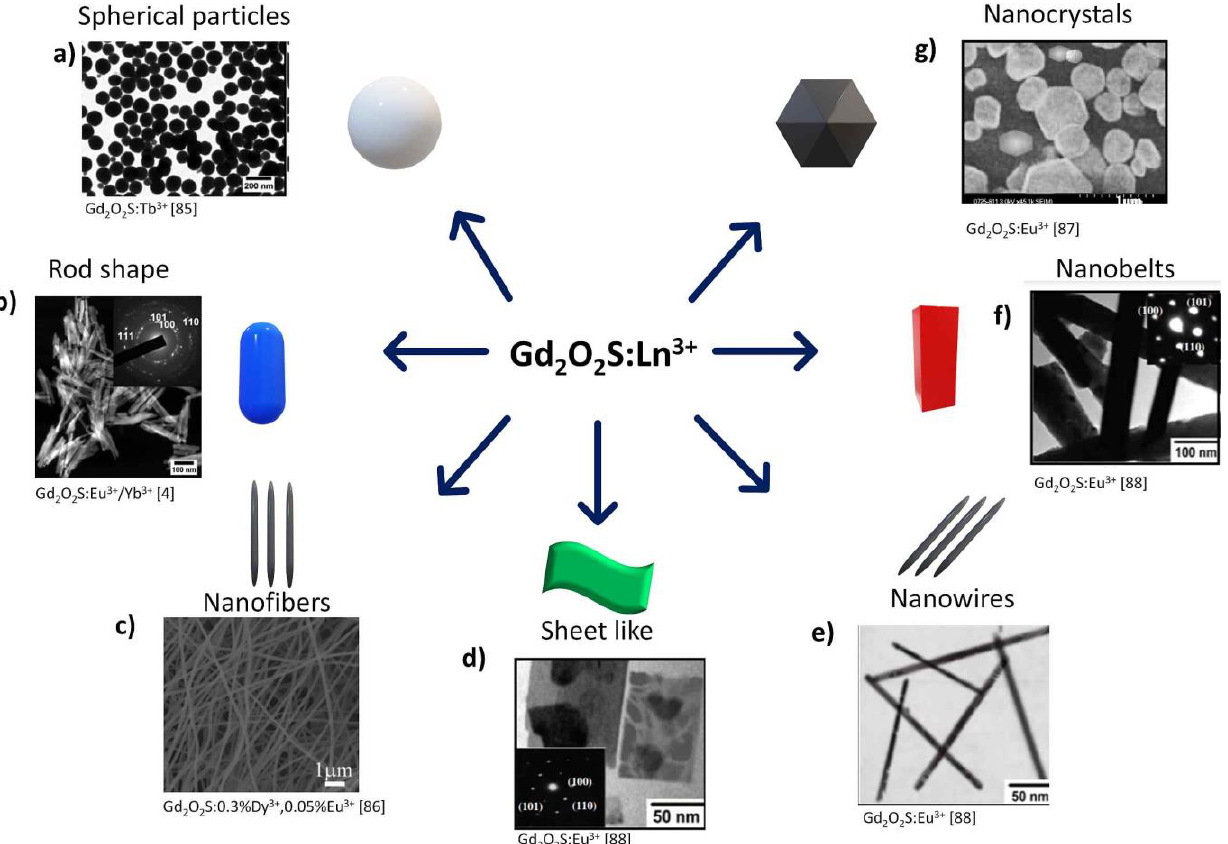
Figure 8. Morphology of gadolinium-based oxysulfide. ( a ) particles with a spherical shape, ( b ) rod-shaped, ( c ) nanofibers, ( d ) sheet-like particles, ( e ) nanowires, ( f ) nanobelts, ( g ) nanocrystals.